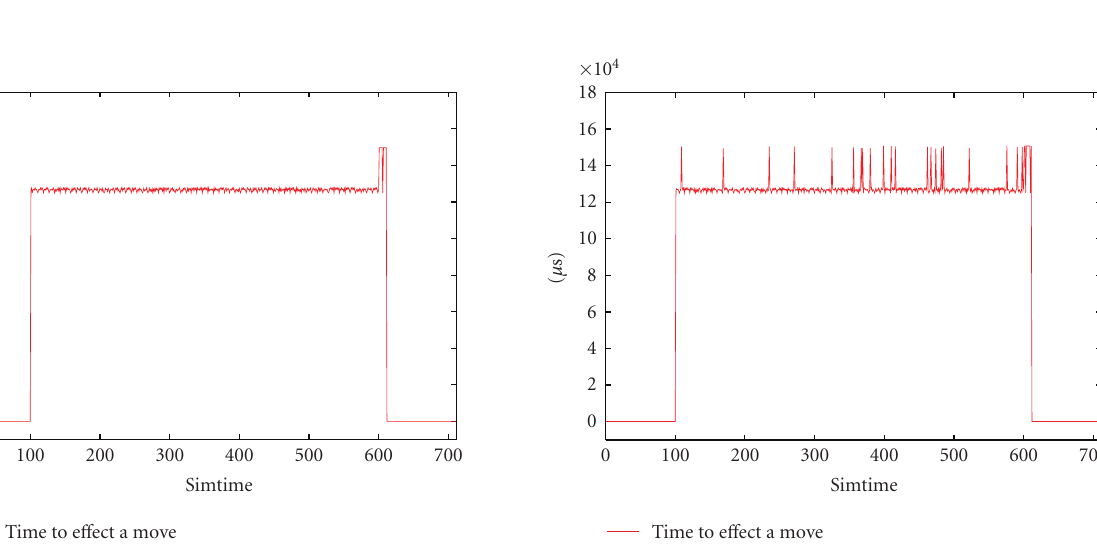
Figure 2: The playing session mechanism.